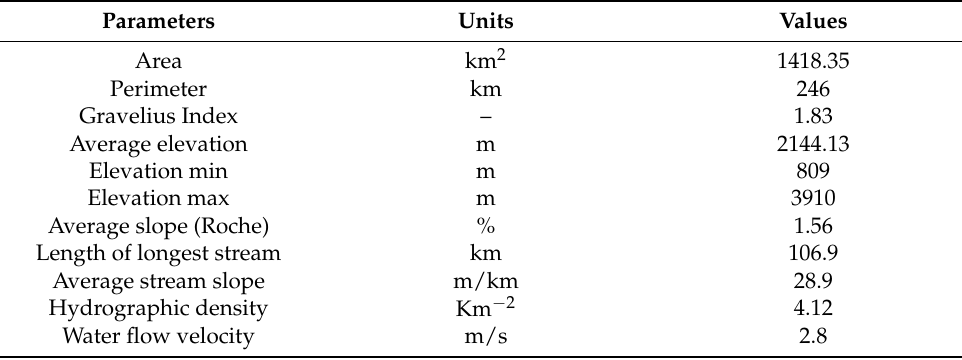
Table 1. Basic characteristics of Tassaoute catchment.